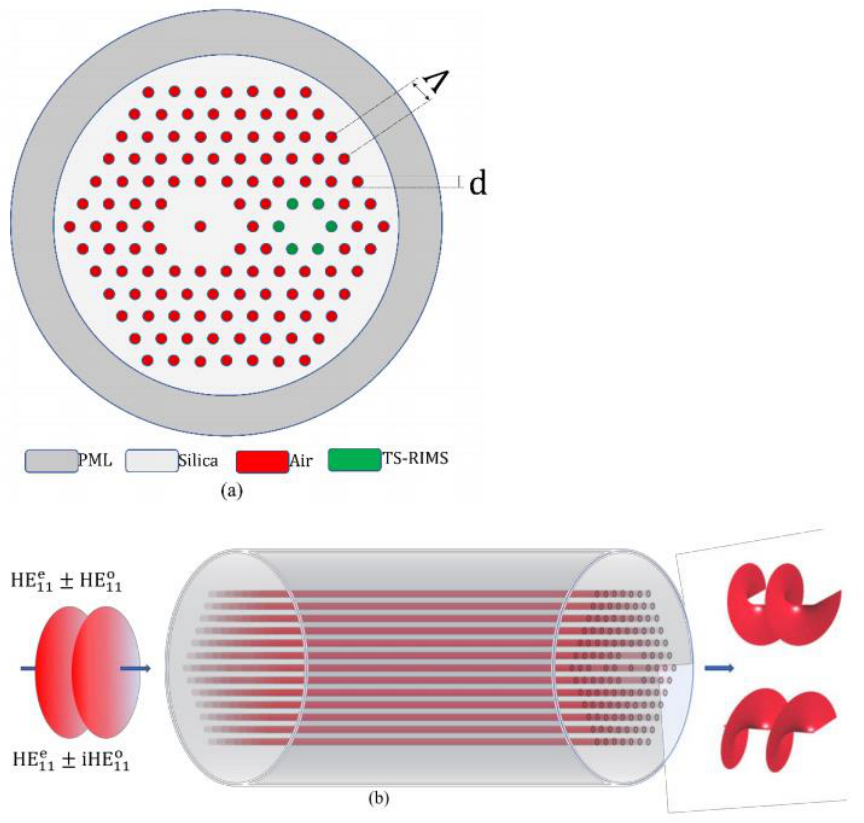
Figure 1. ( a ) Cross-section of the proposed DC-PCF OAM mode generator. ( b ) Working principle and structure diagram of DC-PCF OAM mode generator. The input light can be LPFM or CPFM. The ± 1st order OAM mode can be generated at the output